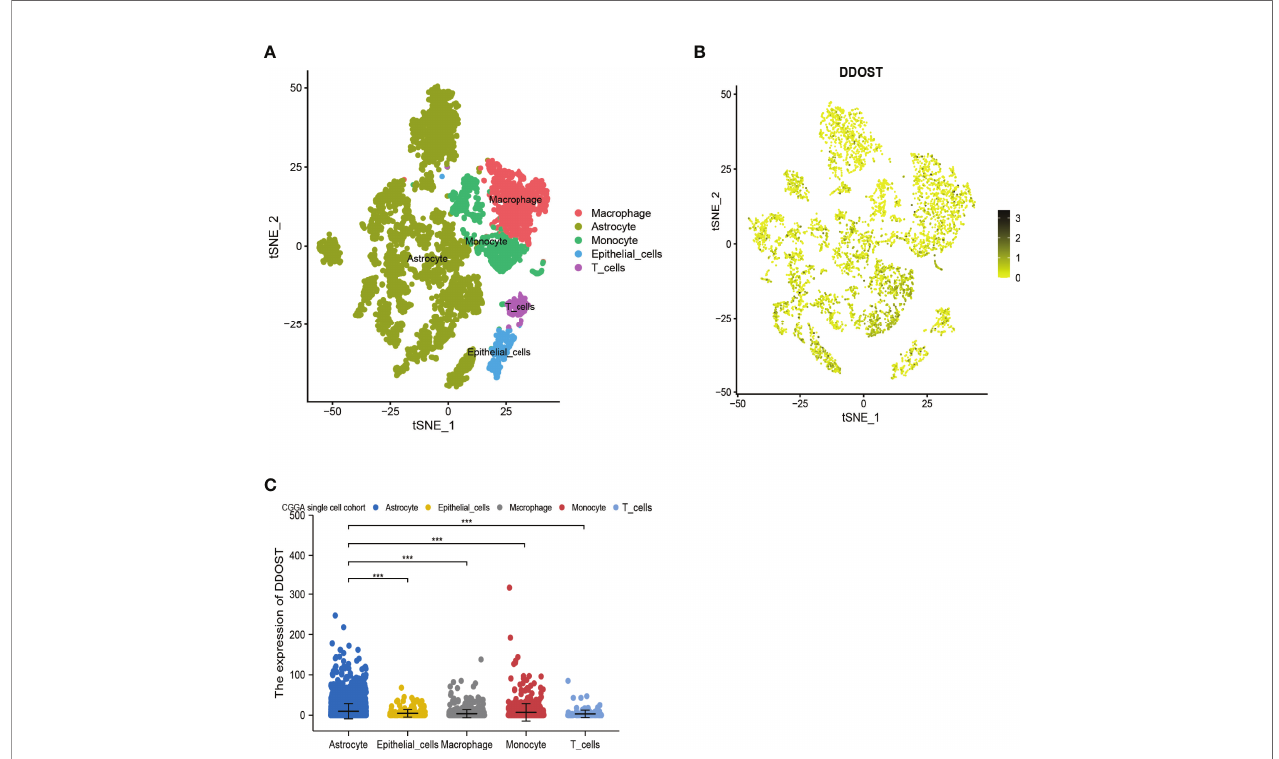
FIGURE 6 | The expression of DDOST in glioma by single-cell analysis. (A) By dimensionality reduction analysis of CGGA single-cell data, 6,148 cells were divided into astrocytes, epithelial cells, macrophages, monocytes, and T cells. (B) Scatter plot of DDOST distribution in glioma. (C) The scatter plot shows the expression of DDOST in astrocytes, epithelial cells, macrophages, monocytes, and T cells. *** p <